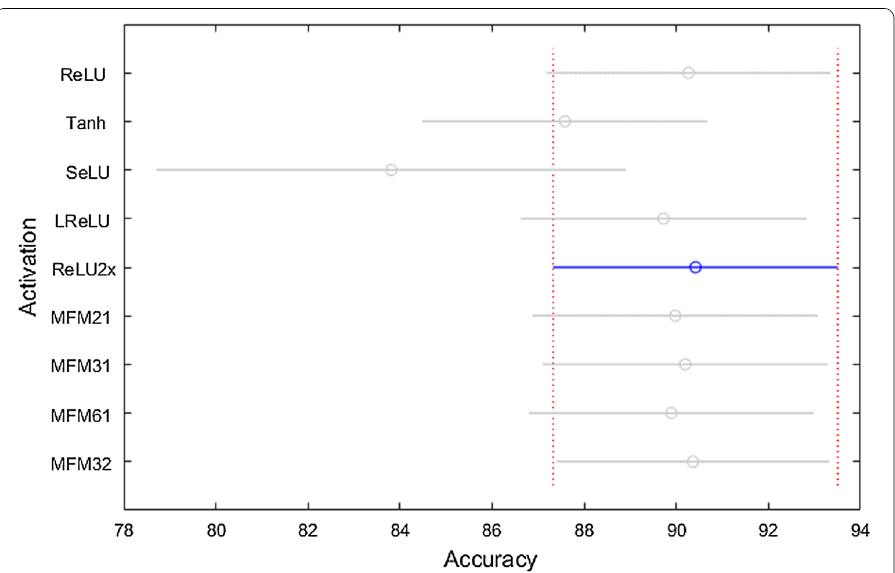
Fig. 12 Multiple comparisons, activations on text